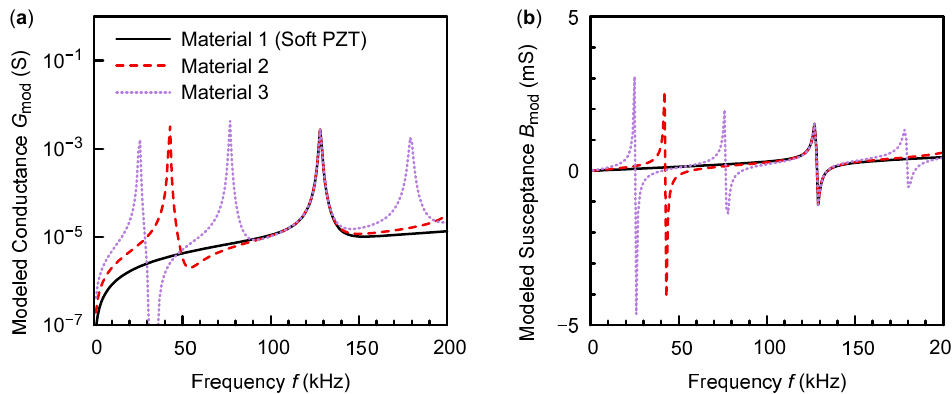
Figure 4. The modeled conductances ( a ) and susceptances ( b ) of three materials. The material constants of the first material (soft PZT) are listed in Table 1. The material constants of the second = ( 2500 − 96i ) (cid:101) = ( 121.2 − 1.4i ) × 10 − 12 m 2 /N, (cid:101) T = ( − 1201 + 34i ) × material are s E 0 , and d 31 33 11 = ( 336.8 − 3.8i ) × 10 − 12 m 2 /N, 10 − 12 C/N. The material constants of the third material are s E 11 = ( 4887 − 205i ) (cid:101) = ( − 3335 + 95i ) × 10 − 12 (cid:101) T 0 , and d 31 33